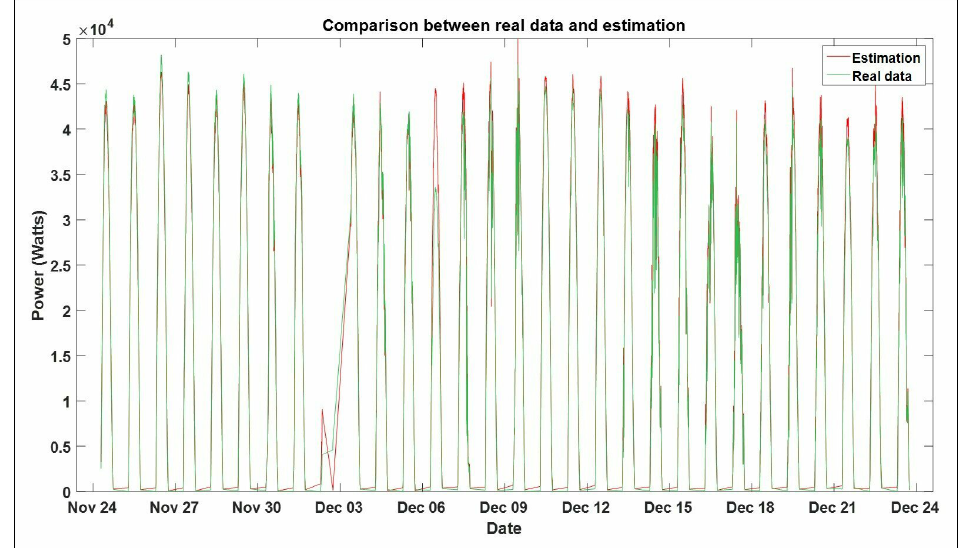
Figure 16. A close-up of the results from